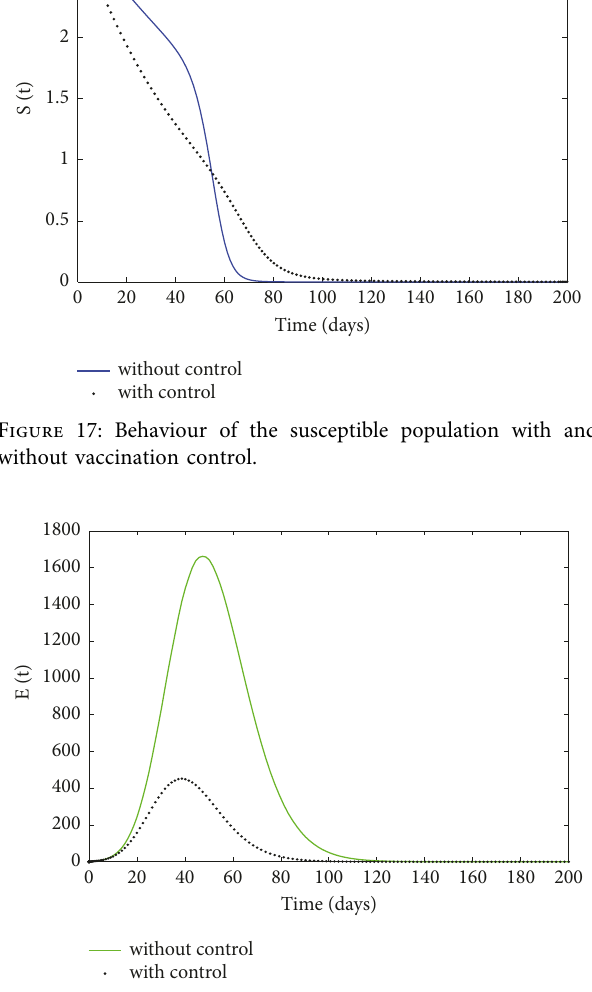
Figure 18: Behaviour of the individuals exposed to COVID-19 with and without vaccination